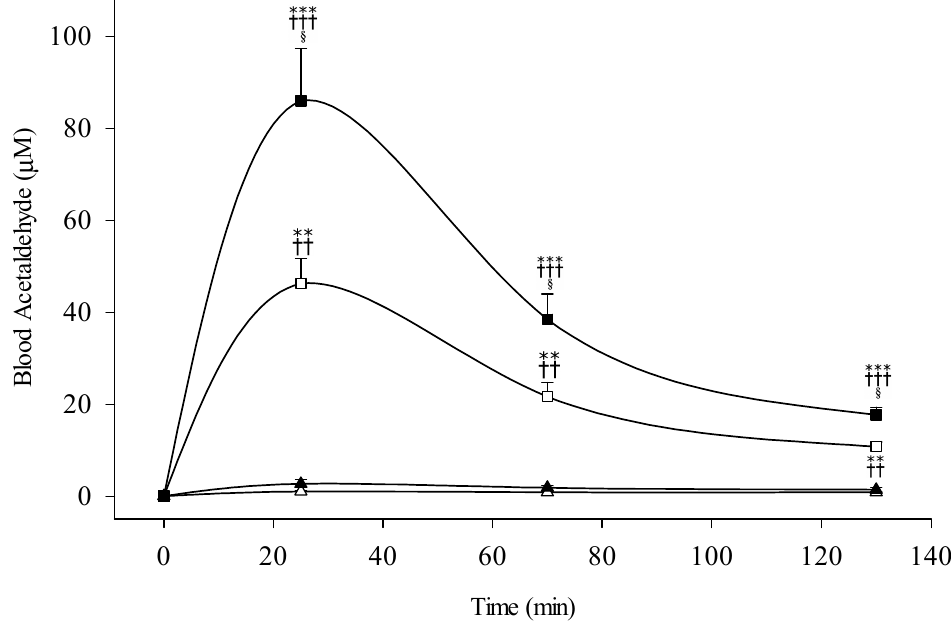
Figure 2. Blood acetaldehyde concentrations of nonalcoholic subjects with different ALDH2 allelo- types following different doses of ethanol (0.3 g/kg body weight or 0.5 g/kg). All subjects are ADH1B*2 homozygote. The study groups are denoted as △ , ALDH2*1/*1 with 0.3 g/kg ethanol ( n = 23); ▲ , ALDH2*1/*1 with 0.5 g/kg ethanol ( n = 21); □ , ALDH2*1/*2 with 0.3 g/kg ethanol ( n = 27); ■ , ALDH2*1/*2 with 0.5 g/kg ethanol ( n = 22). Vertical bars (for clarity only the upper or lower portion shown) represent standard errors of the mean. Statistically significant differences between groups at the corresponding time points was evaluated by ANOVA. *** p < 0.001, ** p < 0.01, vs. ALDH2*1/*1 with 0.3 g/kg ethanol; +++ p < 0.01, ++ p < 0.01 vs. ALDH2*1/*1 with 0.5 g/kg ethanol; § p < 0.05 vs. ALDH2*1/*2 with 0.3 g/kg ethanol.